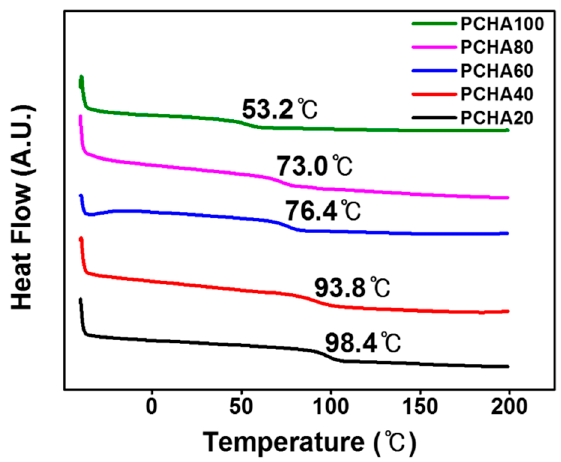
Figure 3. Differential scanning calorimetry (DSC) thermogram of PCHA#.